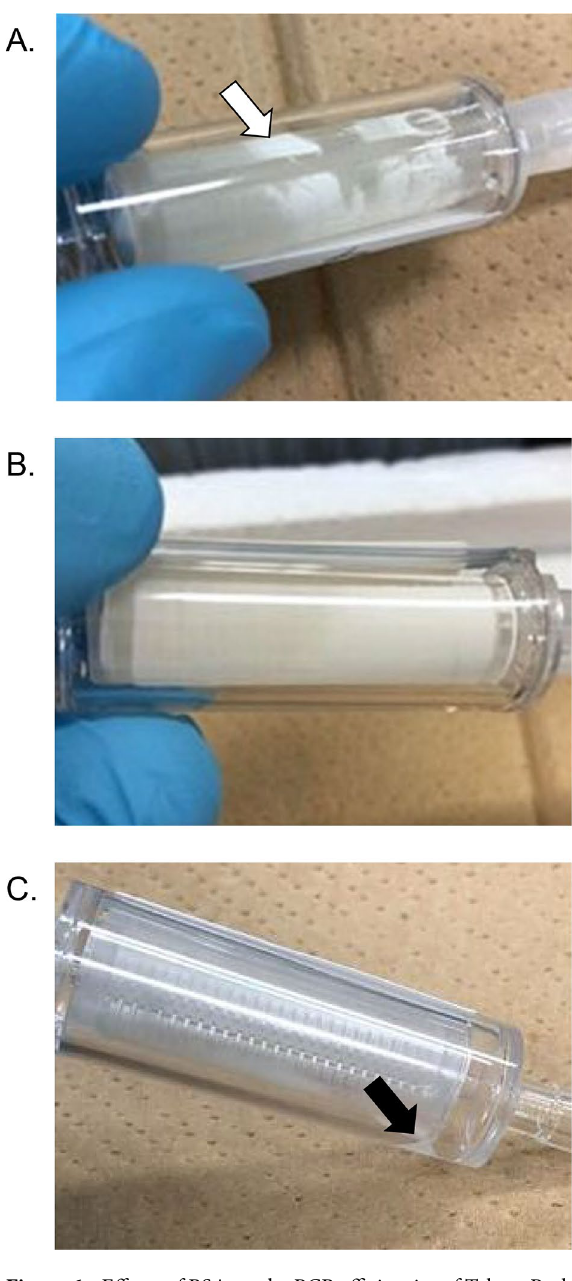
Figure 6. Effects of BSA on the PCR efficiencies of Takara Probe qPCR Mix. ( A ) A field sample known to contain high-level PCR inhibitors was serially diluted and measured by Takara Probe qPCR Mix with or without BSA supplementation. The upper scale bar represents dilution of the field samples. The embedded table shows the PCR efficiency of each dilution curve, and the slope is given in parentheses. PCR efficiency higher than 100% (or slope higher than − 3.322) suggests the presence of PCR inhibitors. BSA supplementation increases adsorption of non-specific inhibitors and restores the PCR efficiency in the inhibitor-rich environmental sample. ( B ) PCR amplification curves of an inhibitor-rich environmental sample. The amplification curves of neat sample shifted downwards, suggesting the reaction was compromised but not entirely inhibited. Dilution of environmental samples restored the parallelism of amplification curves to that of standard, suggesting the inhibition was marginal in this specific